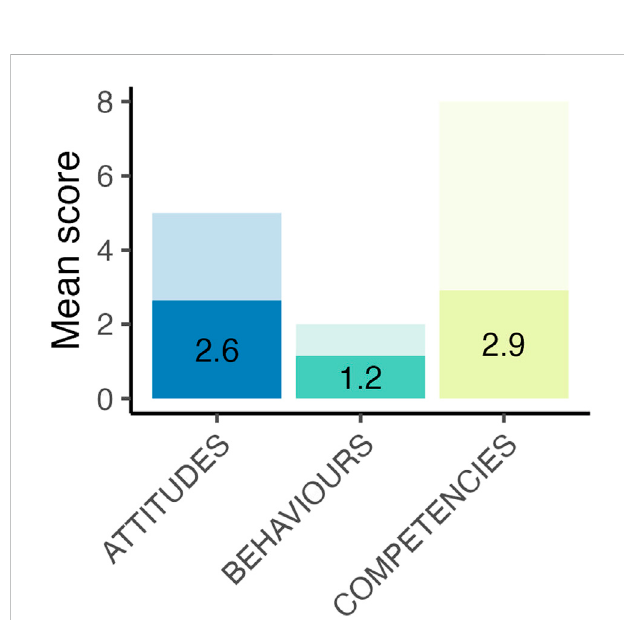
FIGURE 4 Overall soil literacy (solid bars indicate average scores and transparent bars maximum scores of 5 in Attitude, 2 in Behaviours and 8 in Competencies) with percentages given. These results particularly speak to a need of increased educational efforts with respect to increasing knowledge (competencies) around soil which is averaged as 23% correct answers (from Johnson et al,